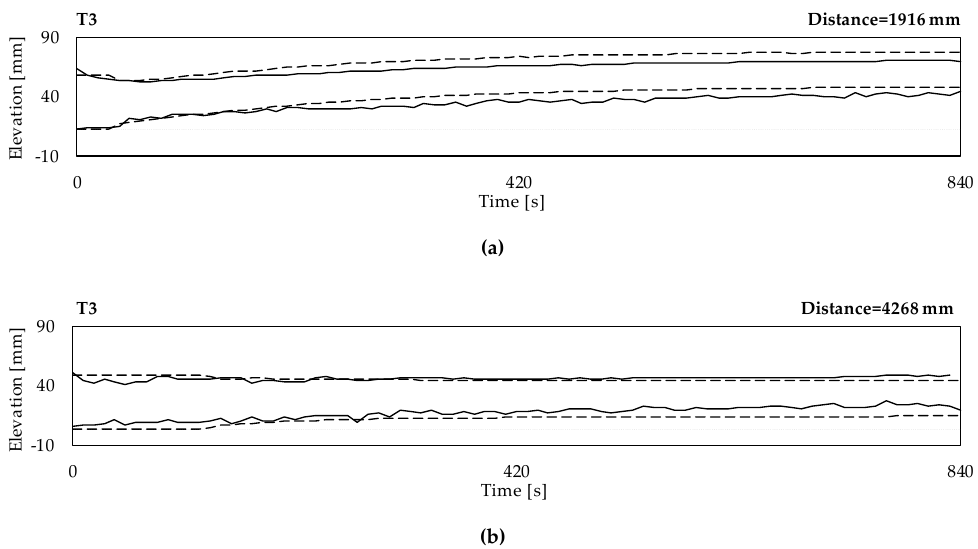
Figure 8. Temporal evolution of bed and water profiles for the experiment T3 obtained experimentally (continuous) and numerically (dashed) at about ( a ) 1.9 m and ( b ) 4.3 m from the channel inlet. The time instant 0 s corresponds to the beginning of the sediment release. The vertical coordinates were measured with respect to the initial bed surface elevation at the channel outlet. The initial bed level is indicated by the gray